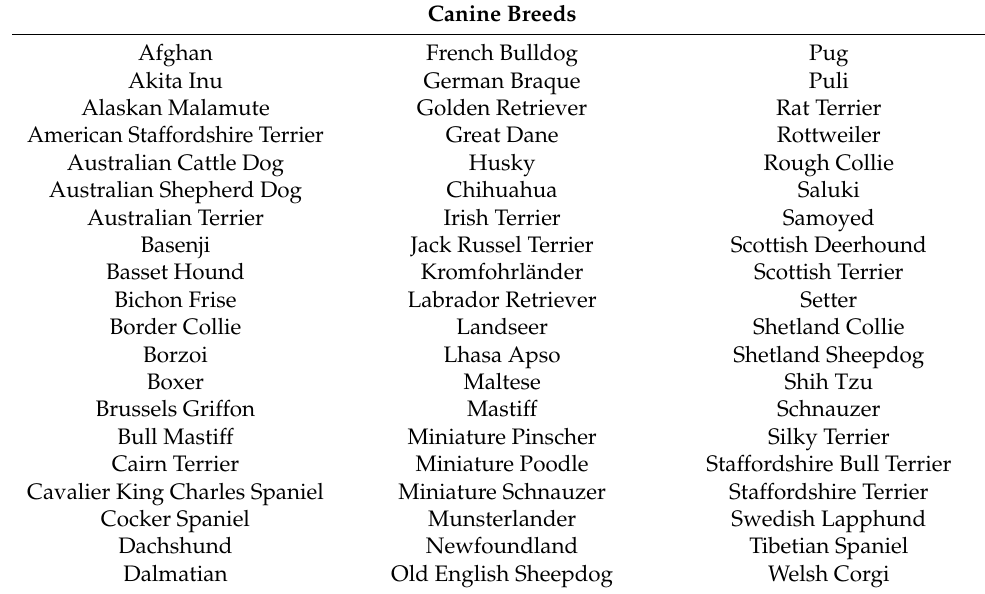
Table 3. The list of canine breeds where cystinuria was reported [20,36,37,44,47,48,55–57,65,70,76–78]. Canine